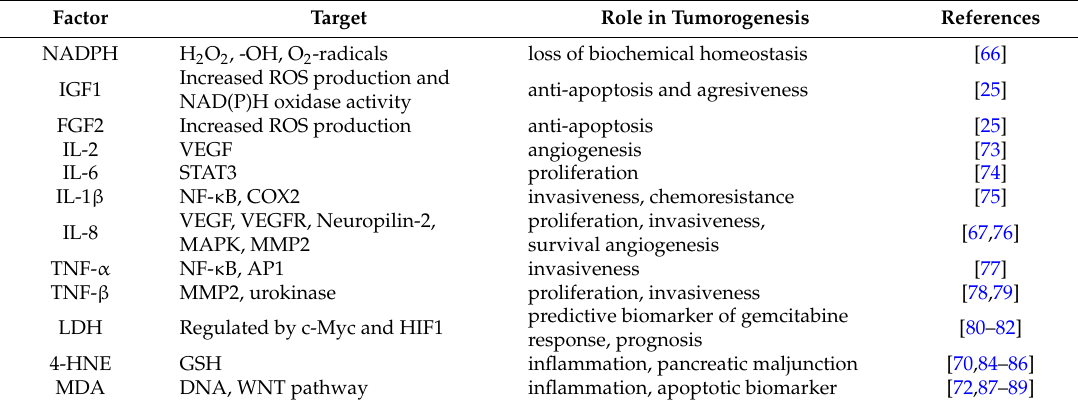
Table 1. Inflammatory cytokines and other factors involved in the pathogenesis of pancreatic ductal